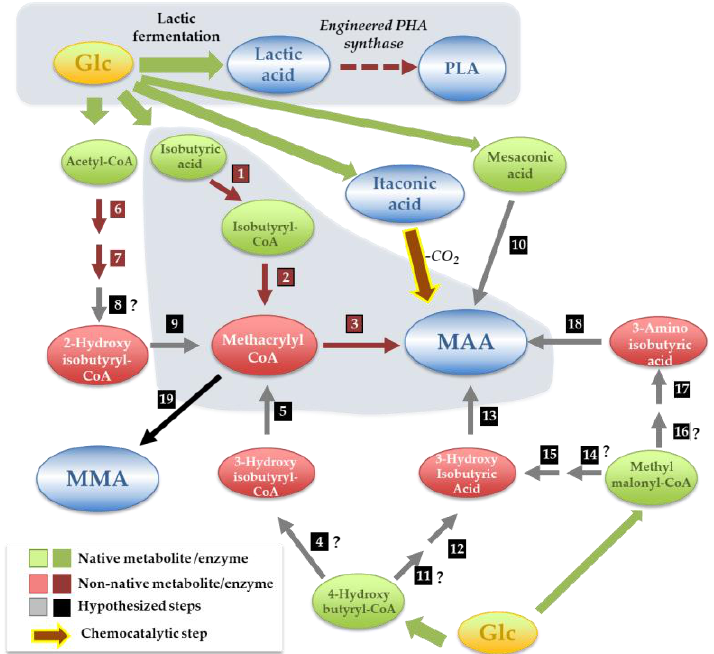
Figure 6. Synthetic poly-lactic acid (PLA), methacrylic acid (MAA) and methyl-methacrylic acid (MMA) production pathways assembled in vivo or identified by in silico metabolic retrobiosynthesis. Detailed information about the enzymes involved in the different steps is provided in Supplementary Table S1. Steps identified by metabolic retrobiosynthesis are indicated in black boxes, and those in which it was not possible to assign an enzyme are marked with “?”. Bio-chemical catalytic conversion of itaconic acid (ITA) to MAA is also shown in the picture as an alternative production method. (1) isobutyryl-CoA synthase; (2) acyl-CoA oxidase; (3) hydroxybenzoyl-CoA thioesterase; (4) 4-hydroxyisobutyryl-CoA mutase; (5) 3-hydroxyisobutyryl-CoA dehydratase; (6) acetoacetyl- CoA thiolase; (7) acetoacetyl-CoA; (8) 3-hydroxyisobutyrate mutase; (9) 2-hydroxyisobutyryl- CoA de-hydratase; (10) mesaconate decarboxylase; (11) 4-hydroxyisobutyryl-CoA mutase; (12) 3- hydroxyisobutyryl-CoA hydrolase; (13) 3-hydroxyisobutyrate dehydratase; (14) methylmalo-nyl-CoA reductase; (15) hydroxyisobutyrate dehydrogenase; (16) methylmalonyl-CoA Reductase; (17) 3- aminoisobutyrate transaminase; (18) 3-aminoisobutyrate ammonia